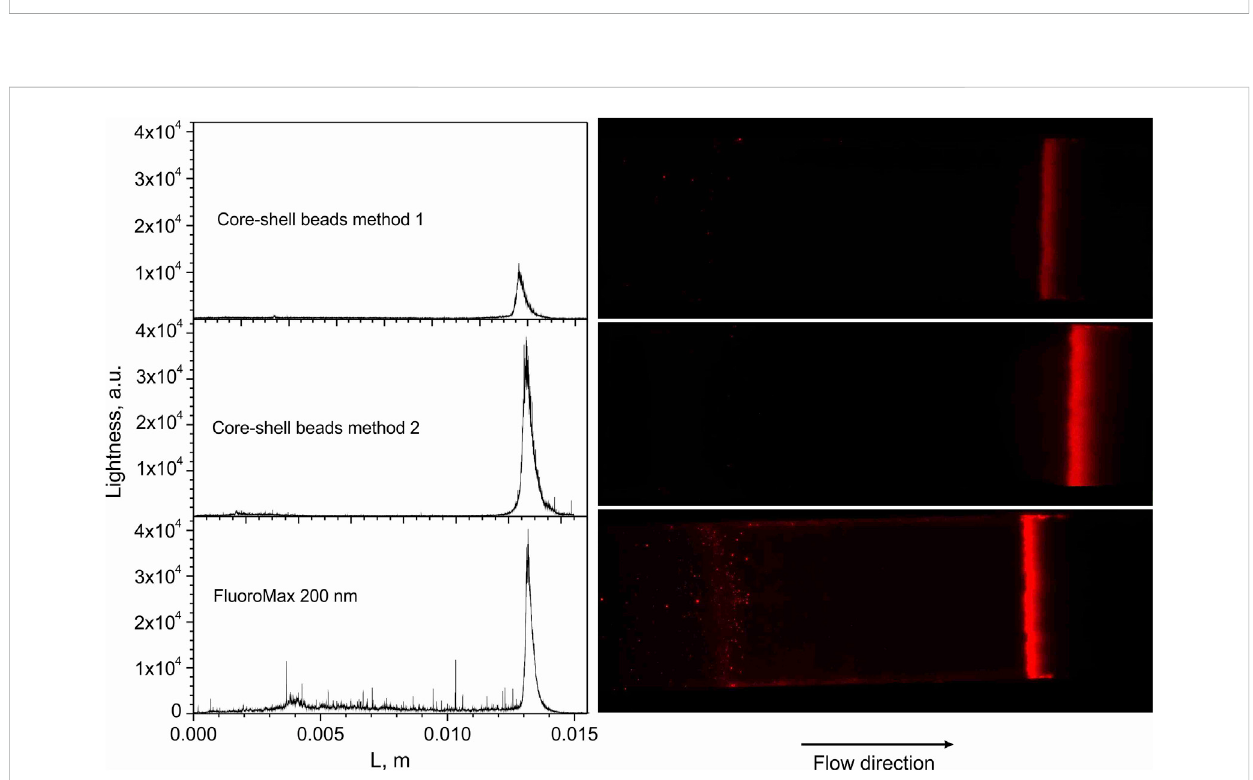
Lightness pro fi les and images from Lateral Flow strips along the chromatograpic fl ow direction from left to right. L is the approximate length from the chromatography start to the test line; the magni fi cation was set to ×10, the exposure time was set to 10 ms. Further details on running media and microscopy may be found in the